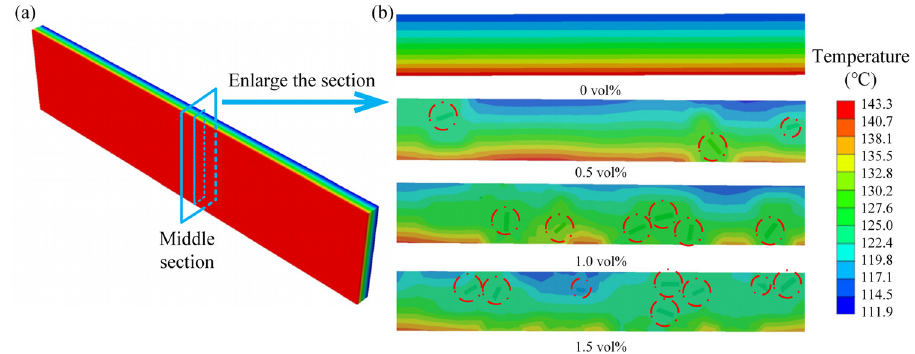
Figure 13: Middle section temperature distribution of SMGO/EP composites with 0 vol%, 0.5 vol%, 1.0 vol%, and 1.5 vol% GO contents.